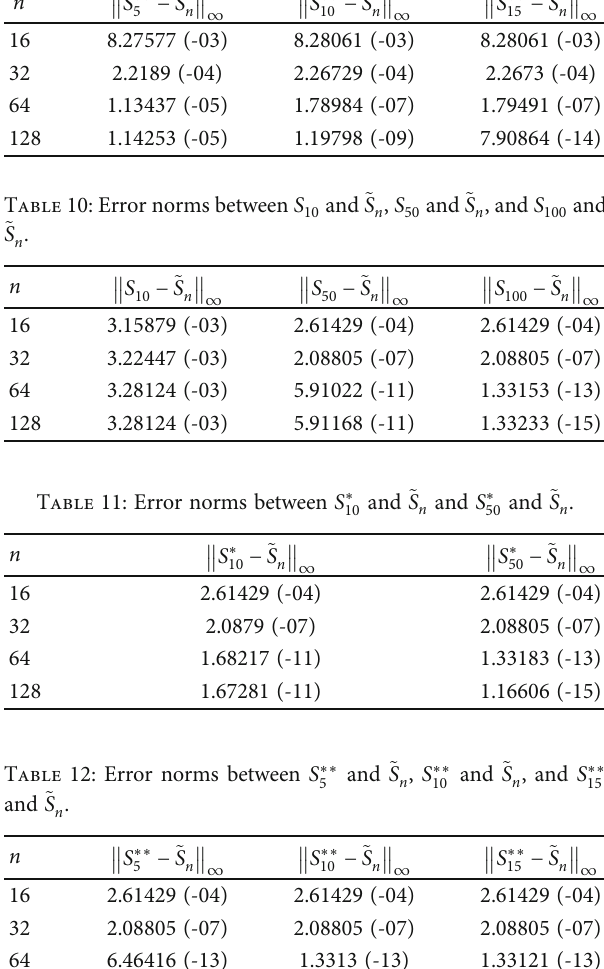
Table 9: Error norms between S ∗∗ ~ . S n